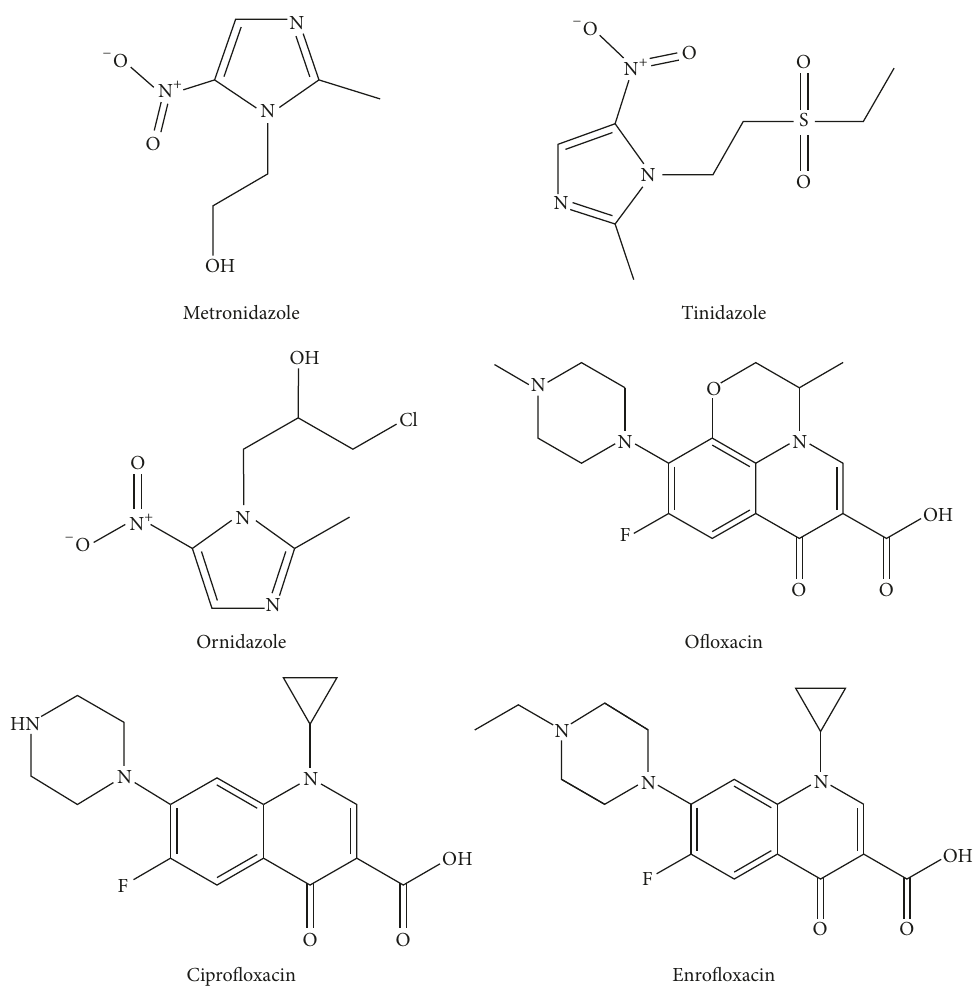
Figure 1: Chemical structures of six nitroimidazoles and